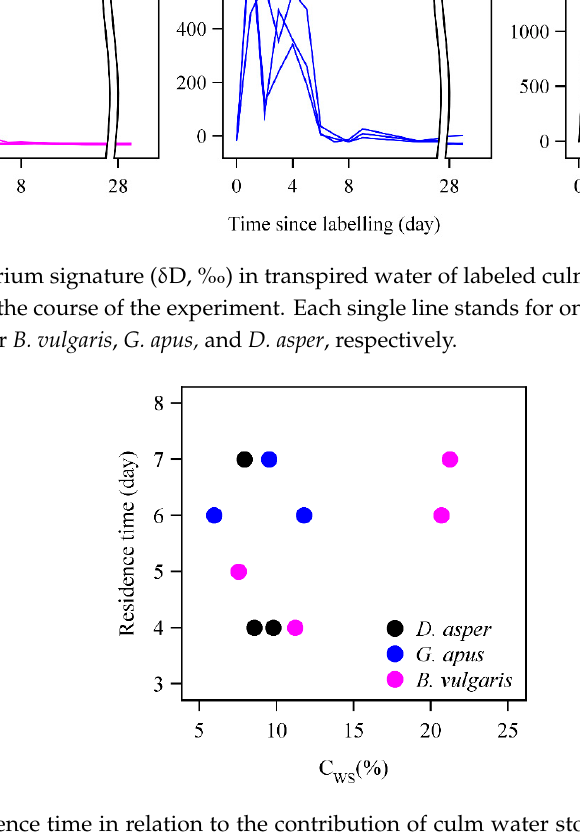
Figure A3. Residence time in relation to the contribution of culm water storage to daily water use (C WS , %).